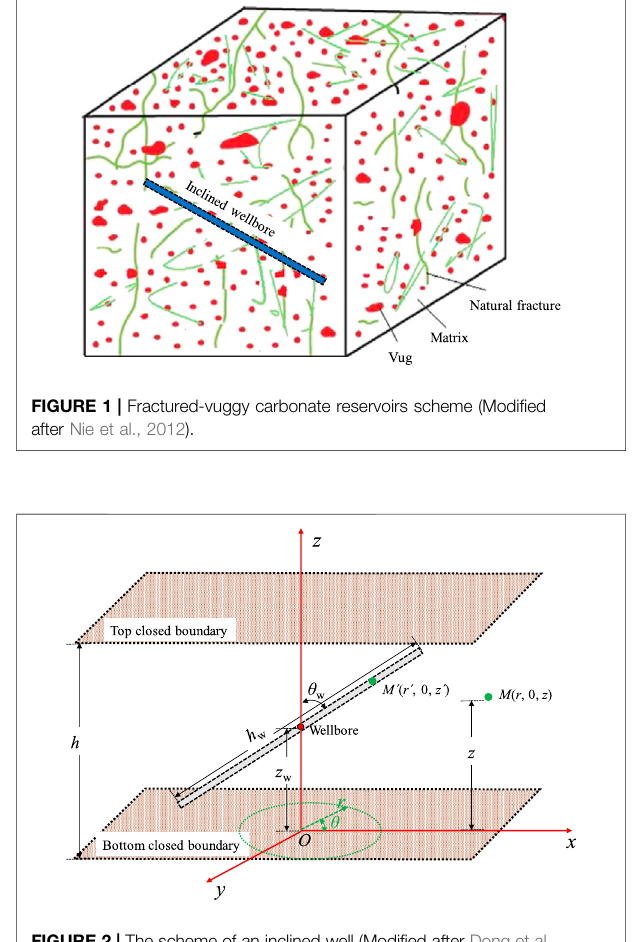
Frontiers in Energy Research |